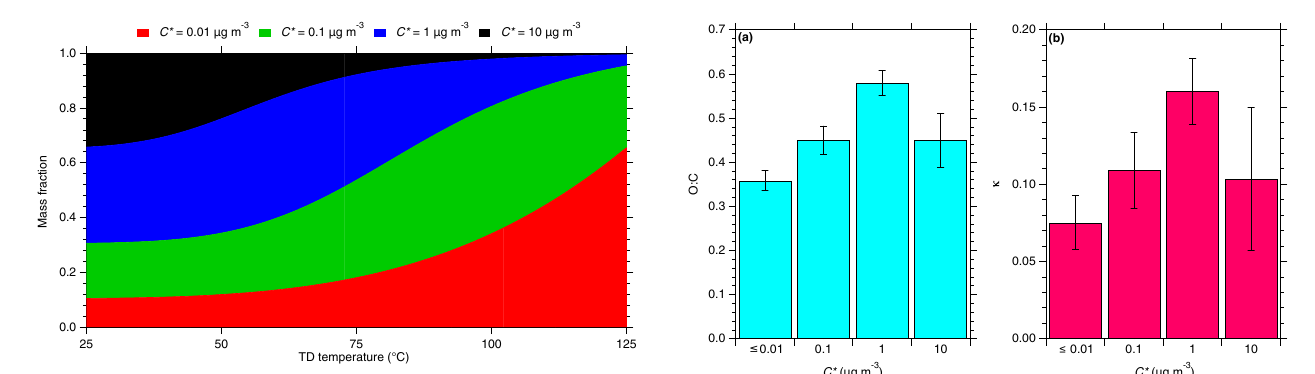
Figure 7. The (a) O:C ratio and (b) κ distributions for the volatility bins characterized in this study for α -pinene ozonolysis SOA. The error bars represent 1 standard deviation of the mean obtained from the least squares